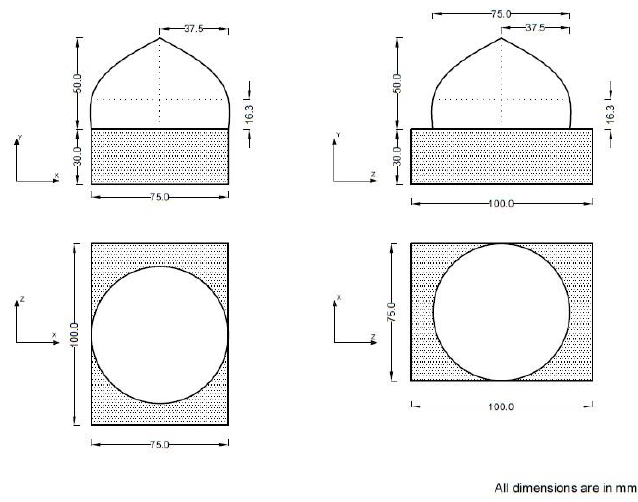
Figure 11. The dimensions of the scaled-down mimicked shape. Based on the dimensions, the mold of the mimicked part was fabricated. The fabricated mimicked mold is represented in Figure